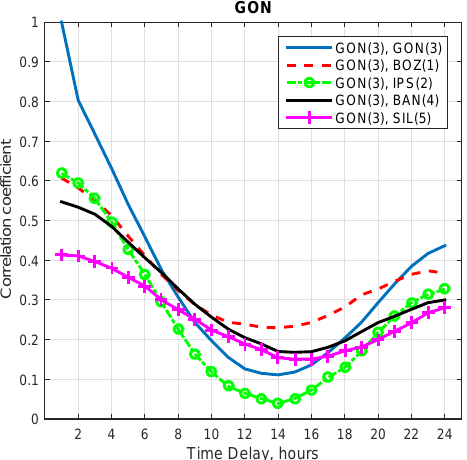
Figure 4. Autocorrelation and cross-correlation coefficients of wind measurements at Bozcaada (BOZ), Ipsala (IPS), Bandirma (BAN), and Sile (SIL) with Gonen (GON) in October–November